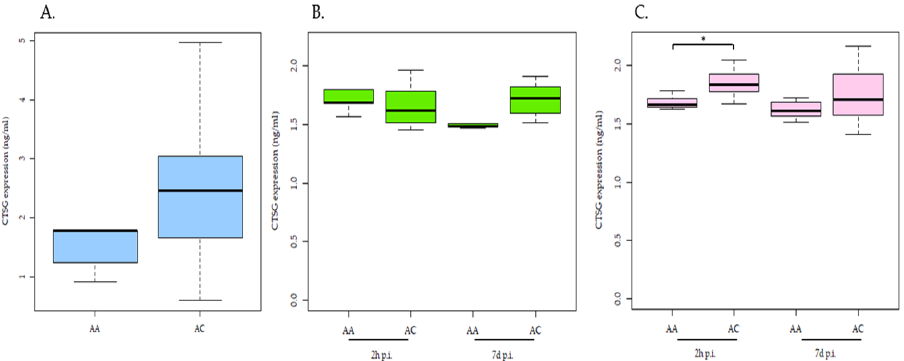
Figure 1. CTSG levels in carriers of different genotypes of cis-eQTL-rs41976219. MDMs and CD14+-MDMs purified from 16 cows with the homozygous (AA; n = 5) and heterozygous (AC; n = 11) genotypes for rs41976219 infected ex vivo with MAP for 2 h and 7 days. CTSG levels measured in plasmas ( A ) and supernatants of MDMs ( B ) and CD14+-MDMs ( C ) after 2 h and 7 d of MAP in- fection by ELISA. Statistically significant differences are observed in the mean CTSG levels of ex- pression in the supernatants of MAP-infected CD14+-MDMs after 2 h of infection depending on the genotype of the cis-eQTL-rs41976219. The median and upper and lower quartiles of each group are represented by horizontal and vertical lines, respectively. The lowest point is the minimum of the dataset and the highest point is the maximum of the dataset. p -values are calculated using an un- paired t -test. * p -value ≤ 0.05.